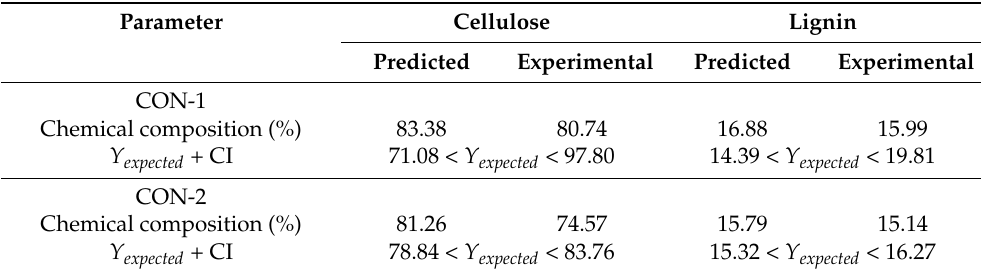
Table 5. Comparative analysis of predicted and experimental Y expected values at the optimal 1qqqqq- condition for the chemical composition of cellulose (CON-1) and lignin (CON-2).